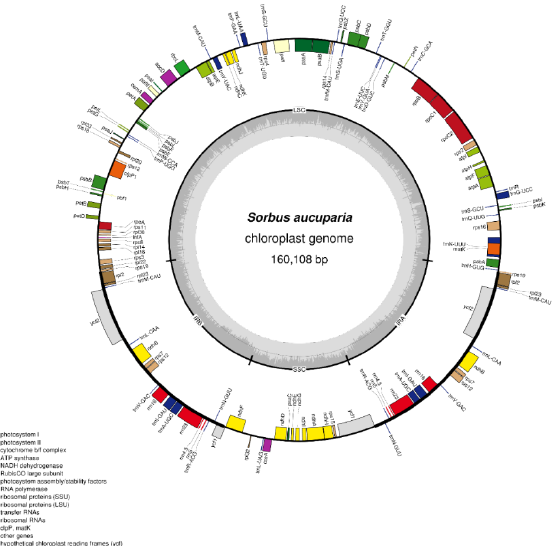
Figure 1. Chloroplast gene map of Sorbus aucuparia . Genes are grouped in categories highlighted in various colors. If a gene is transcribed clockwise it is shown on the inside of outer circle; if transcribed counter-clockwise it is shown on the outside of outer circle. The inner circle shows genome regions: LSC — large single-copy; SSC — small single-copy; IR(A/B) — inverted repeat.